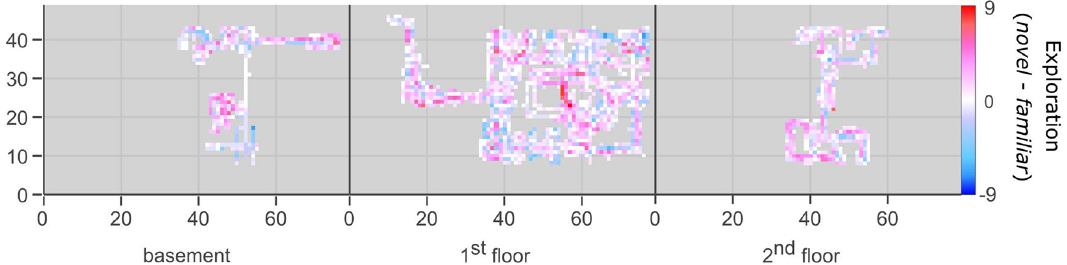
Figure 4. On day 2, participants explored more space in novel than in familiar environments (collapsed across diagnosis ). The scale represents the difference in number of participants who visited a tile, with red tiles visited more often in the novel condition and blue tiles in the familiar condition. The first floor also included the starting area (left hand side) as well as a garden and stables (right hand side). Note that since the visualization only shows the “mansion” environment, it is based on only one half of the sample.